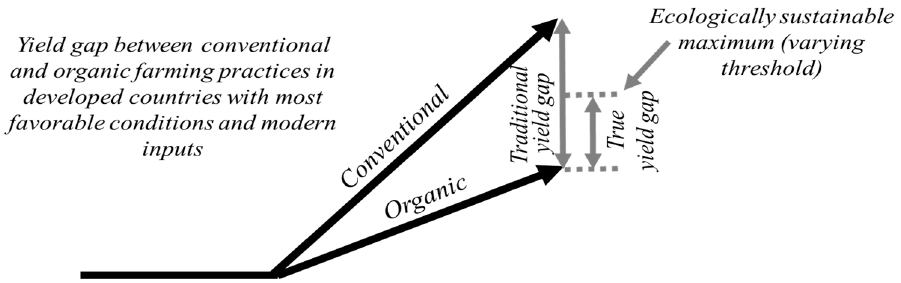
Figure 2. The true yield gap between organic and intensive conventional management shrinks when an ecologically sustainable threshold is set as benchmark.